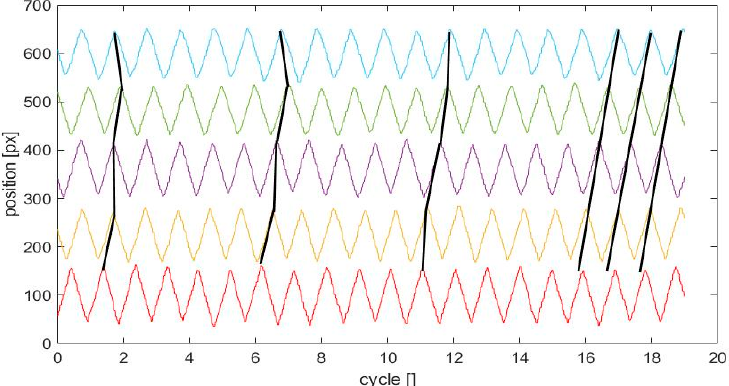
Figure 7. Repetition of the control experiment in glycerol; compare this to Figure 5b. Note, again, emergence of metachronal coordination after about 15 cycles. Herein, the observed metachronal wave runs in opposite direction to the one documented in Figure 5, bottom. For explanation of the lines see the figure caption in Figure 5.